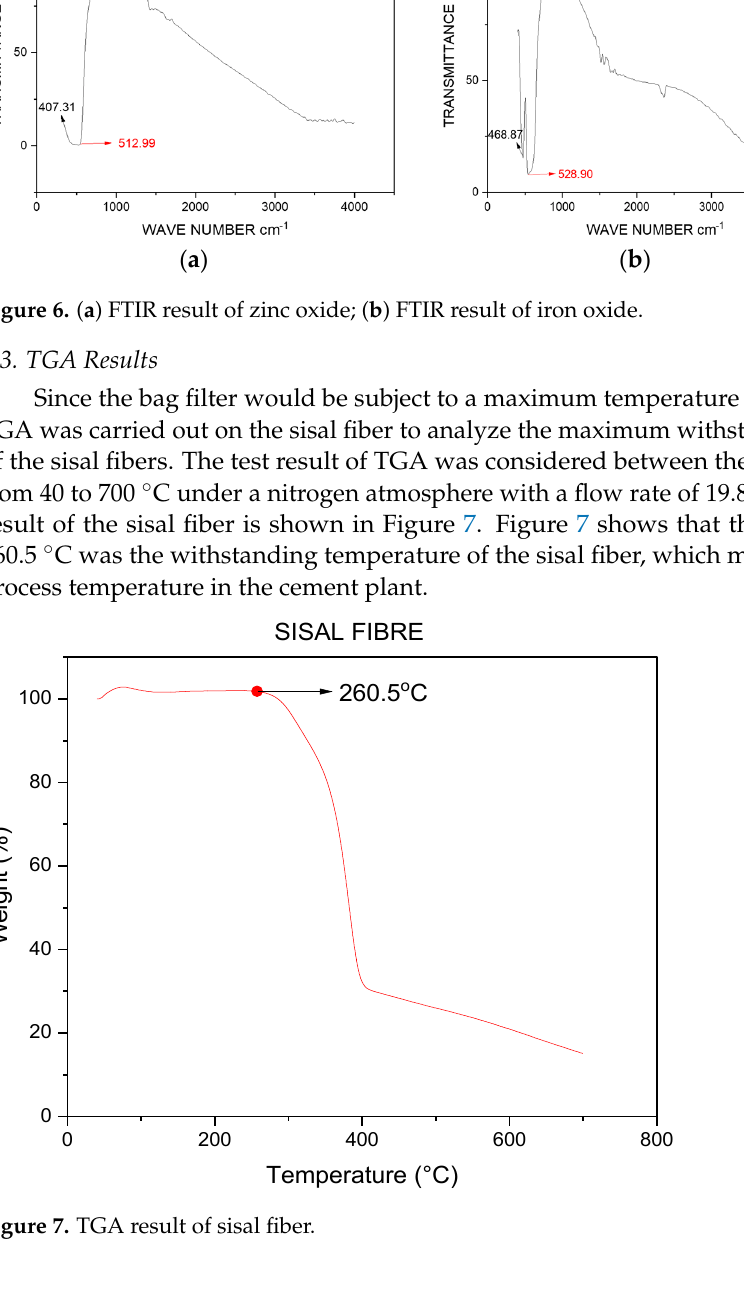
Figure 5. ( a ) SEM image of uncoated sisal fiber; ( b ) SEM image of zinc oxide-coated sisal fiber; ( c ) SEM image of iron oxide-coated sisal fiber.